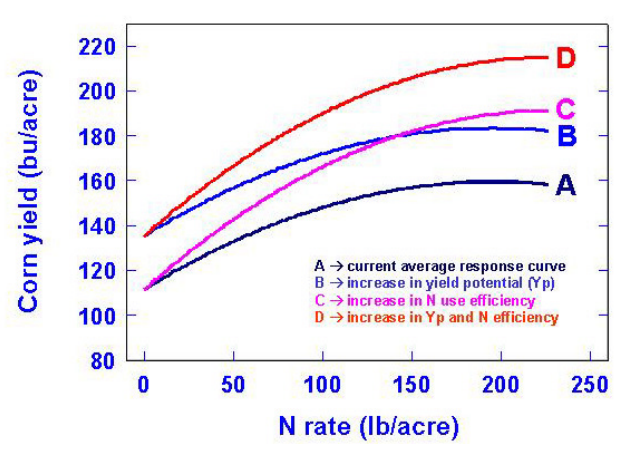
FIGURE 2. Current average response of corn yield to N fertilization rate, shown with response after potential increases in yield potential, N-use efficiency, and both (from plenary presentation by K.